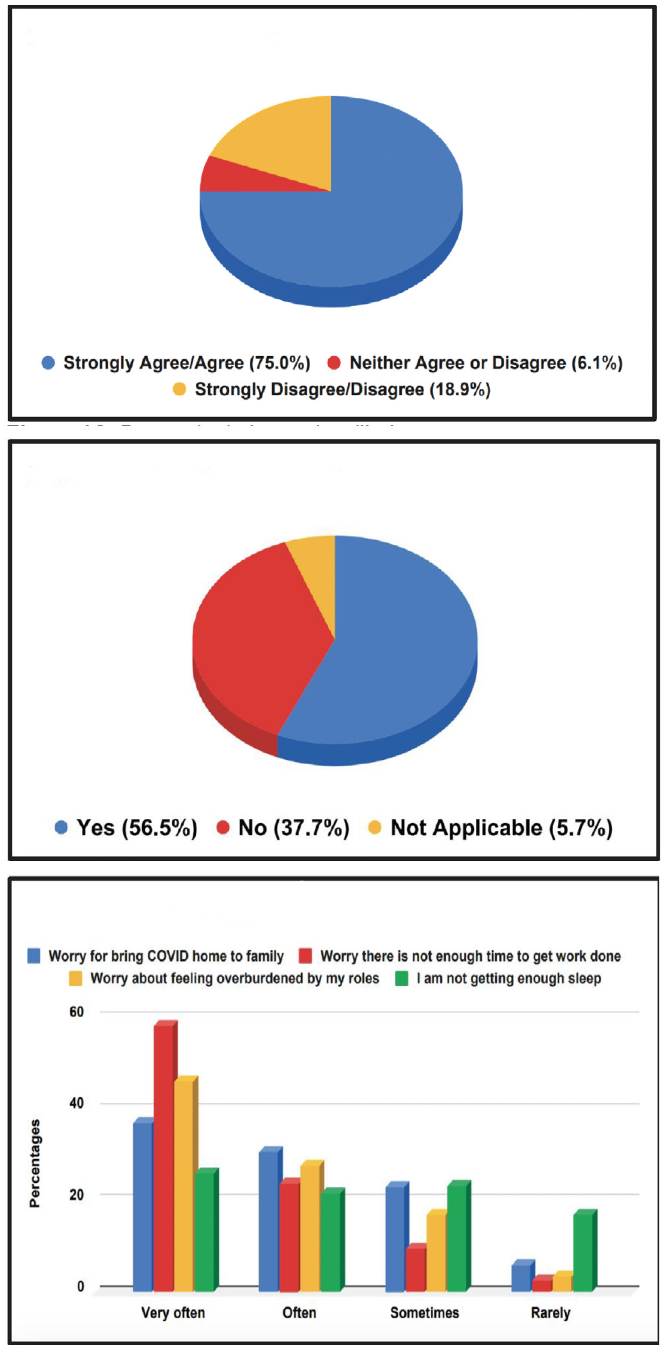
Figure 1. Domestic duties and wellbeing of survey respondents. (A) Respondents who experienced a disruption in childcare. (B) Respondents who experienced difficulties securing childcare. (C) Respondents who experienced indicators of physician burnout.